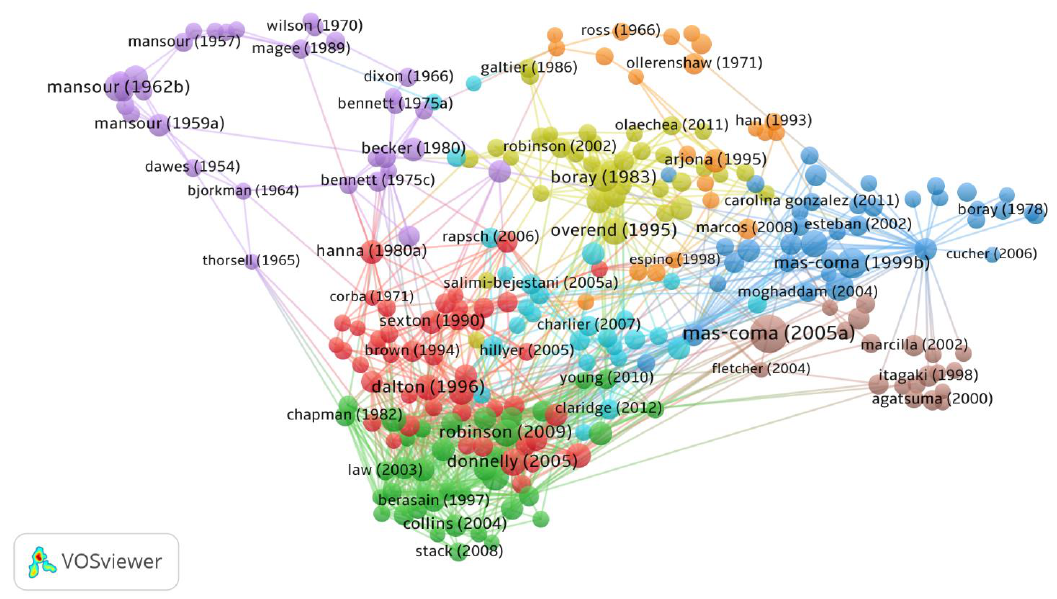
Figure 7. Network visualization of citation and documents based on citations.